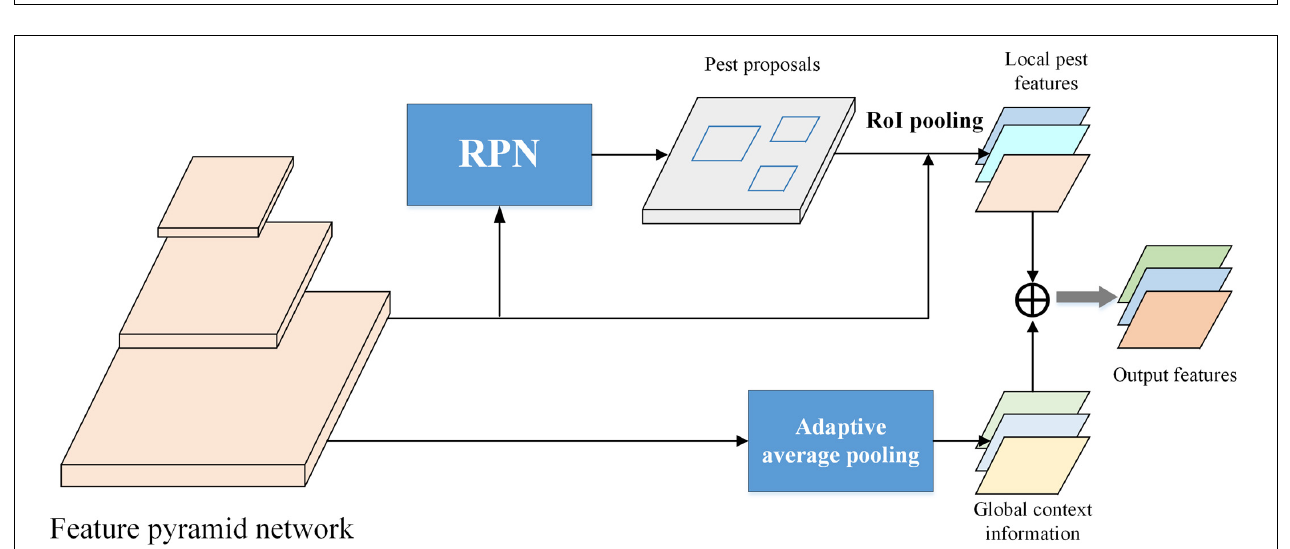
FIGURE 6 | Description of global context-aware feature